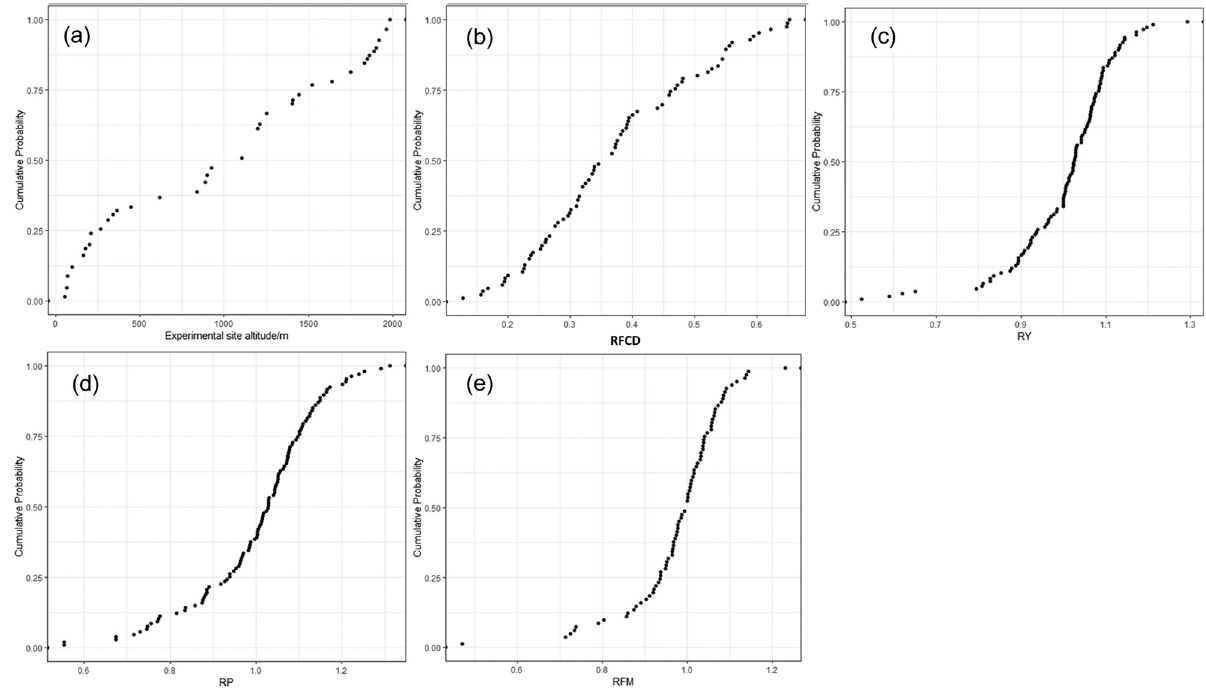
Figure 2: Cumulative probability distribution of altitude ( a ) , RFCD ( b ) , RY ( c ) , RP ( d ) , and RFM ( e ) in all experimental